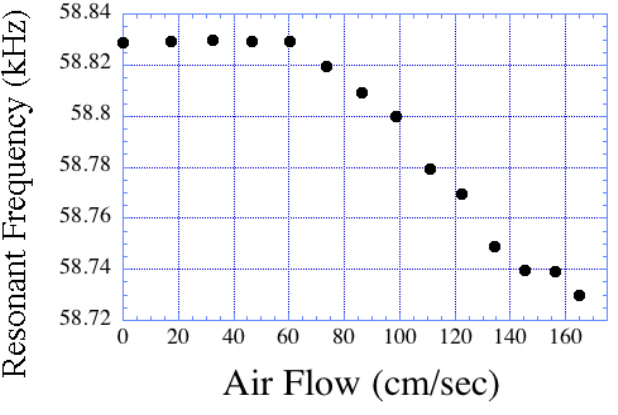
Figure 19. The resonance frequency shift of a magnetoelastic sensor as a function of air flow velocity. The transition to turbulent flow is not seen within this velocity regime. Reprinted with permission from